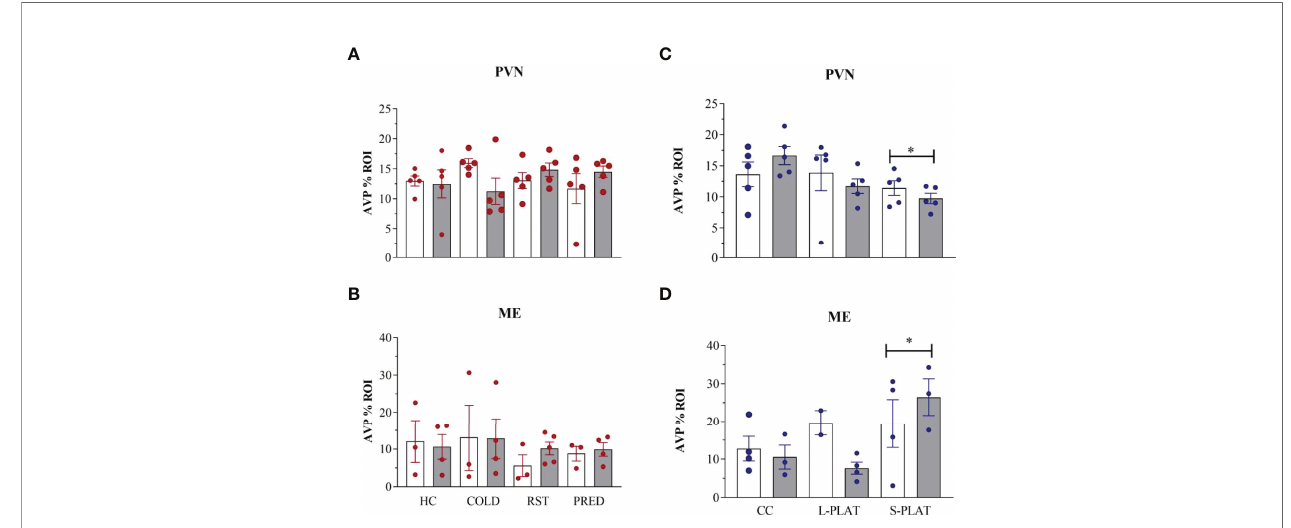
FIGURE 3 | AVP-ir in the PVN and external zone of the ME after several stressors (A, B) or after PSD (C, D) . Quanti fi cation of staining is shown for each individual and the columns represent the mean ± SEM of 2 to 5 rats/subgroup. HC, home cage; RST, restraint stress; PRED, predator odour; CC, container control; L-PLAT, large platform; S-PLAT, small platform. White columns represent single or 1-day exposure and grey columns, repeated or 4-day exposure. * = different from respective control